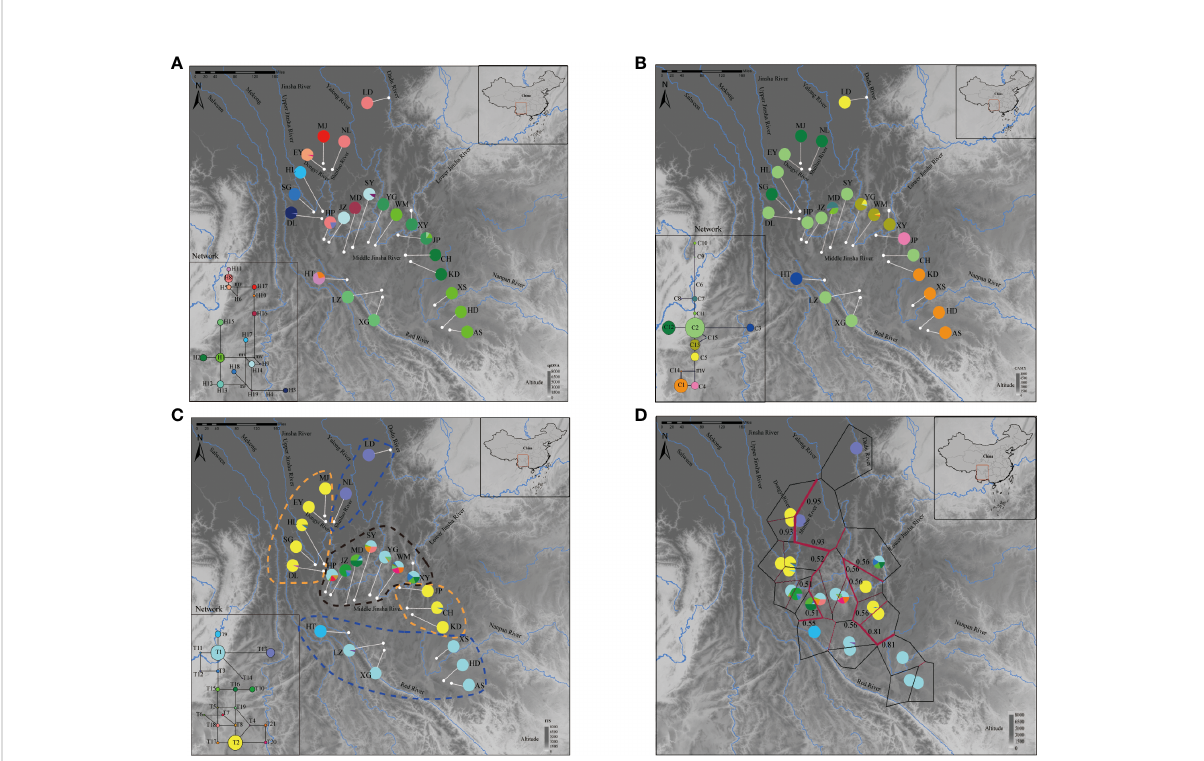
FIGURE 2 Geographical distribution of haplotypes and BARRIER analysis of H. lichiangensis . (A – C) Haplotype distributions for 23 populations based on (A) cpDNA, (B) CAMX , and (C) ITS data matrices. Frequencies of haplotypes in each population are indicated by the pie diagrams. The lower left inset of each panel are results from haplotype network analyses. (D) BARRIER analysis based on combined nDNA data. The detected barriers are indicated by heavy red lines. Numbers near the lines indicate bootstrap